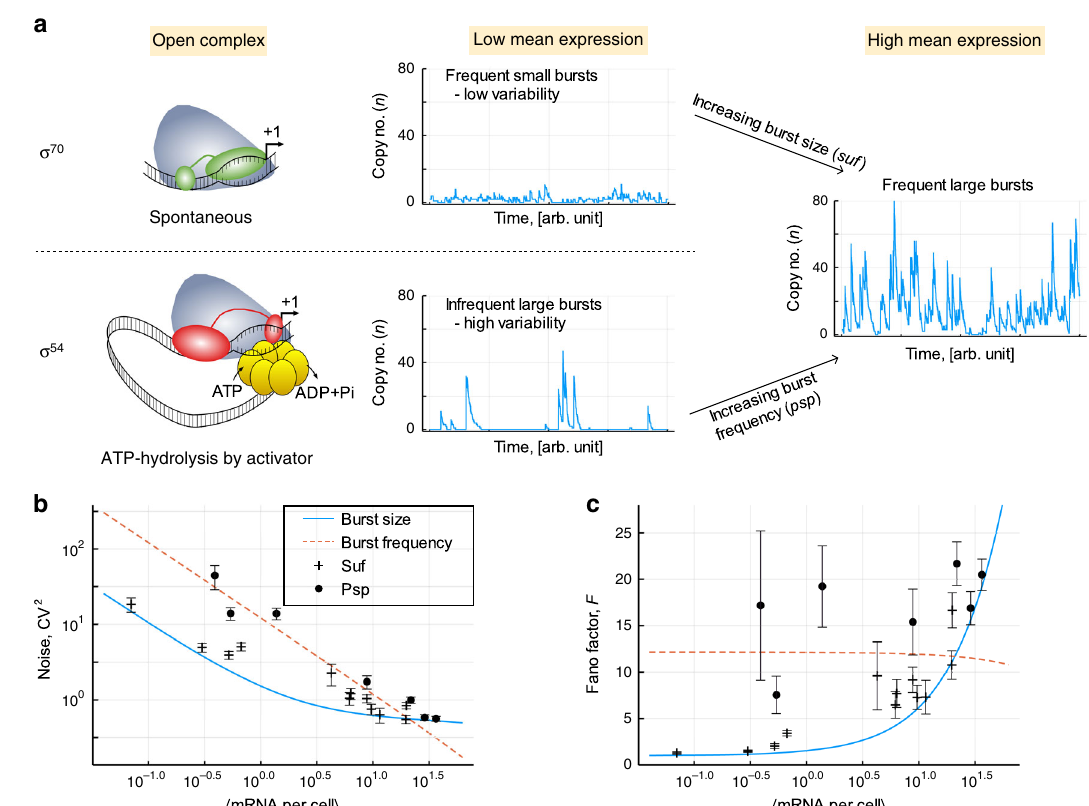
Fig. 7 Comparison of noise scaling and bursting mechanisms of σ 70 and σ 54 controlled transcription. In bacteria, the form of transcriptional bursting is determined by the route to transcription initiation. We observe that for σ 70 controlled promotors in which open complex formation occurs spontaneously, regulation occurs by relieving repression, corresponding to a reduction of the parameter ν . Low expression levels therefore consist of relatively frequent but small bursts that lead to low variability ( a ). For σ 54 controlled promotors in which open complex formation requires ATP-hydrolysis dependent activation, regulation occurs by increasing the rate at which this activation occurs. Low expression levels in this case correspond to large but infrequent bursts, leading to large variability ( a ). At high expression levels, both types of promotor may converge towards similar behaviour. The relationships between mean expression level and the Noise ( b ) and Fano factor ( c ) can be expressed mathematically in each of these cases, provided that regulation is via only one of burst size or burst frequency. These expressions are provided in materials and methods and plotted in ( b ) and ( c ) along with the measured cell behaviour. Data are presented as the statistic of the full set of data samples + / − the SEM obtained from n = 10,000 bootstrap strains from the KEIO collection of Escherichia coli mutants 60 as donors or by lambda red recombineering 61 . Strains were typically grown in Luria-Bertani (LB) broth or on agar at 37 °C. For RNA fl uorescence in situ hybridization, strains were grown in M9 minimal medium (Teknova) at 37 °C, from an inoculum of 150 μ l from an LB overnight culture to a fi nal OD 600 of 0.4 in a culture volume of 30ml in a 250 ml fl ask. The bacterial cultures were supplemented as required with anti- biotics at the following concentrations: chloramphenicol 30 μ g/ml; kanamycin 25 μ g/ml. Exposure to isopropyl β -D-1-thiogalactopyranoside (IPTG) at 1mM fi nal concentration for 1 hour was used to express pIV from plasmid pGZ119EH. Arabinose 0.02 – 0.2% ( w / v ) and glucose 0.4 – 1% ( w / v ) were used to express PspF (PspF low , PspF high , PspF WT , PspF W56A , PspF T86S and PspF W56A + T86S ) from pBAD18-cm in cells lacking chromosomally encoded pspF . Fluorescent probes . Fluorescent DNA probes (purchased from LGC Biosearch Technology) to detect the mRNA of sufABCD and pspABC structural genes were designed using the Stellaris ® Probe Designer version 4.2; the oligo length was set at 20 nt, the minimal spacing length at 2 nt and the masking level at 1 – 2. The probes were labelled by 6-carboxytetramethylrhodamine, succinimidyl ester (6-TAMRA). RNA fl uorescence in situ hybridization . Bacterial cells were grown in M9 medium to an OD 600 of 0.4 and collected by centrifugation. Cells were fi xed in 1ml of ice-cold 1× PBS in DEPC-treated water with 3.7% ( v / v ) formaldehyde (30 min incubation at room temperature), washed twice in 1ml 1× PBS in DEPC-treated water, permeabilised in 1ml 70% ( v / v ) ethanol in DEPC-treated water (1h gently mixing at room temperature) and washed again in 1ml 2× SSC in DEPC-treated water with 40% ( w / v ) formamide. Hybridisation was performed through incubation of the cells overnight at 30 °C in hybridisation buffer (2x SSC in DEPC-treated water, 40% ( w / v ) formamide, 10% ( w / v ) dextran sulfate, 2mM ribonucleoside- vanadyl complex, 0.2mg/ml BSA and 1 mg/ml carrier E. coli tRNA) with 1 μ M of